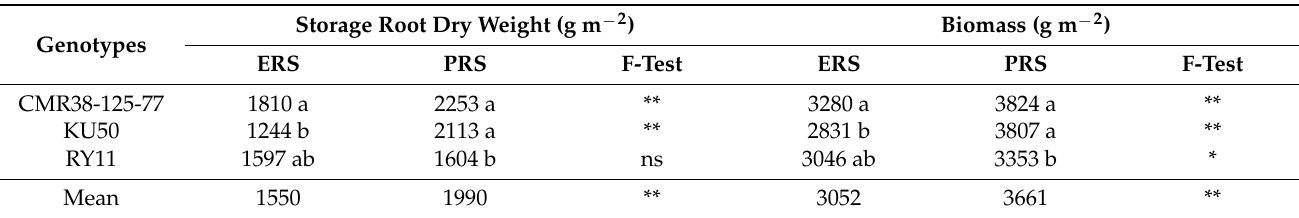
Table 5. Storage root dry weight and biomass (g m − 2 ) of three cassava genotypes in the early rainy season (ERS) and post rainy season (PRS) with full irrigation.